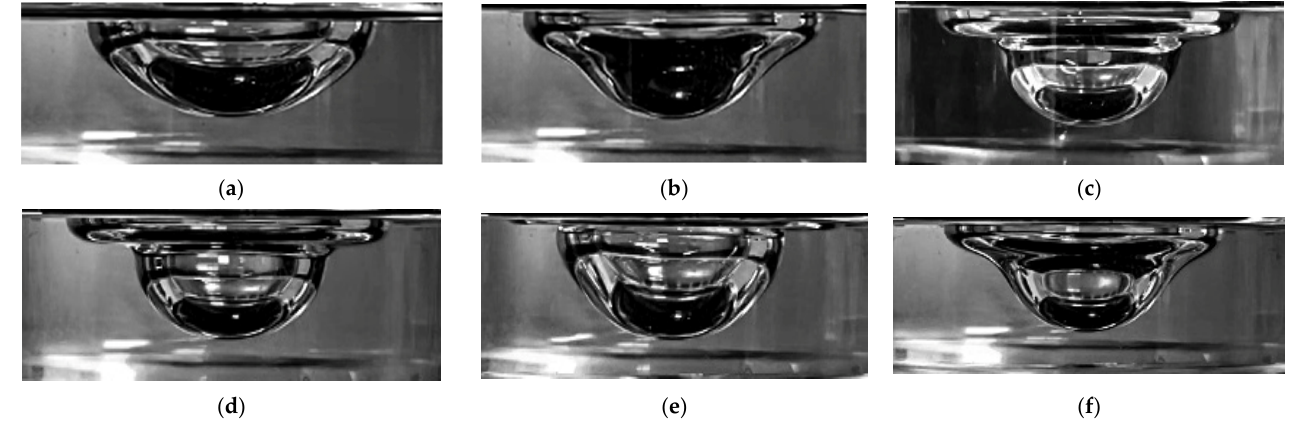
Figure 3. Surface fluctuation of the liquid pool at different moments of the gas jet impinging.